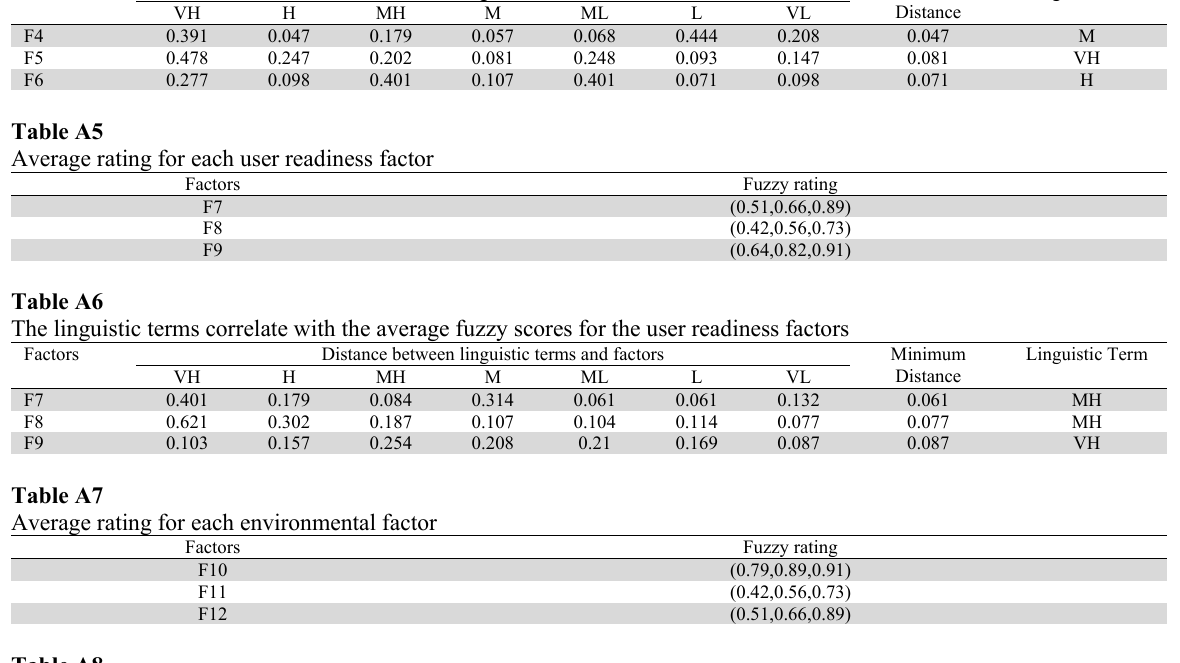
The linguistic terms correlate with the average fuzzy scores for the institutional factors Factors Distance between linguistic terms and factors Minimum